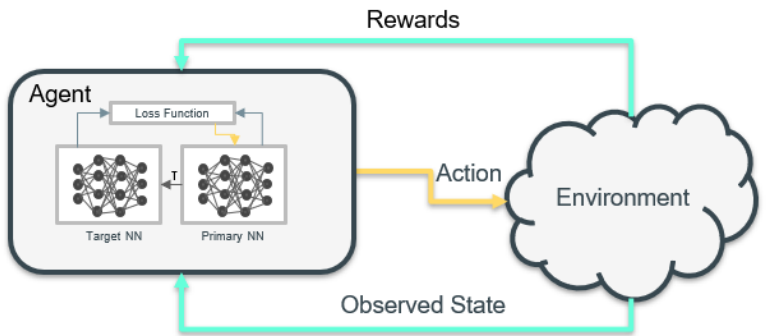
Figure 7. DQL with target NN.